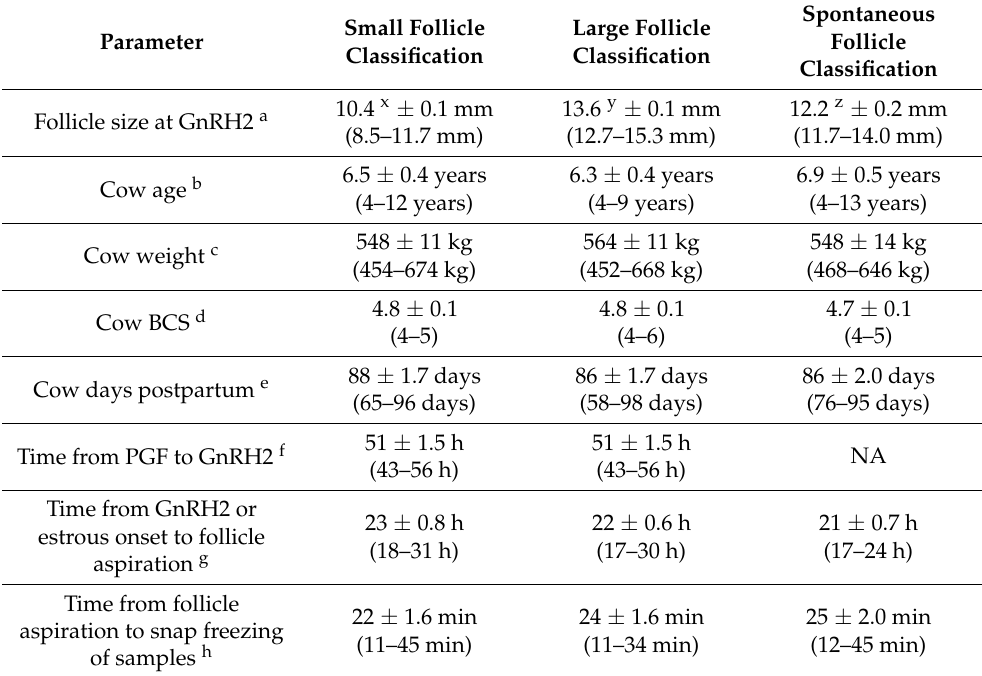
Table 1. Parameters associated with the collection of oocyte and cumulus cell pools for small, large, or spontaneous